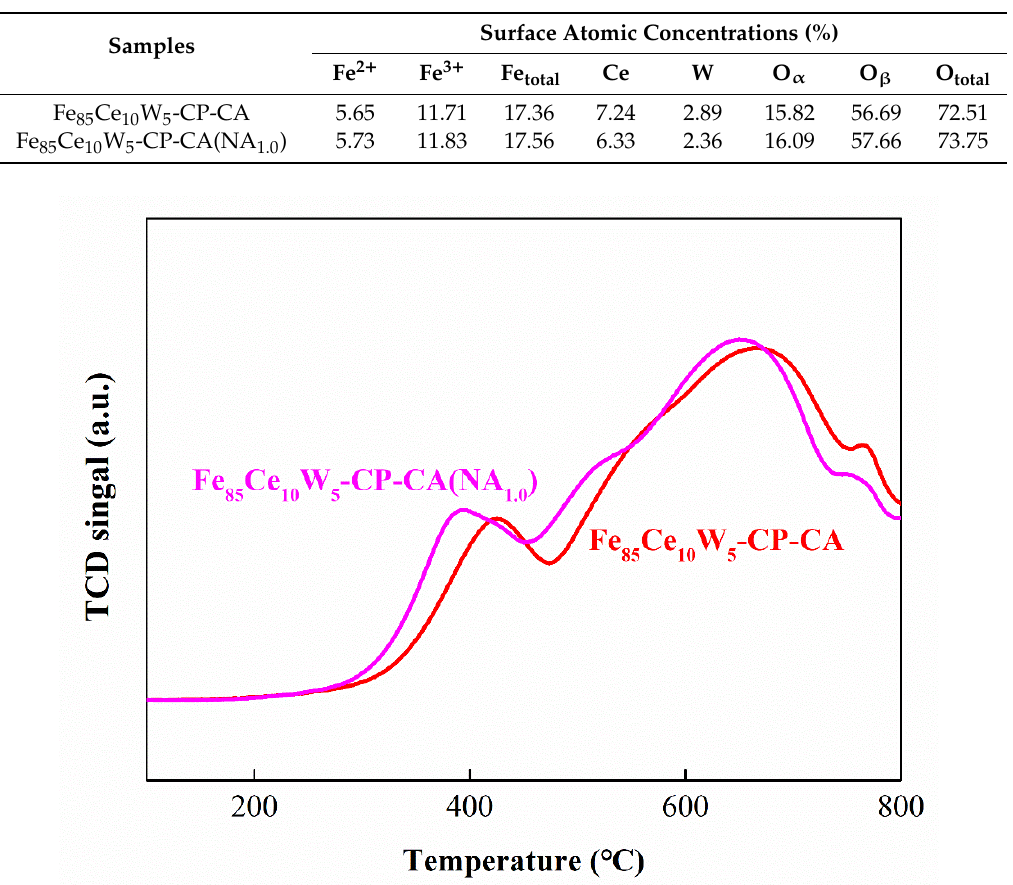
Figure 6. H 2 -temperature program reduction (H 2 -TPR) profiles of the catalysts. Table 3. The X-ray photoelectron spectroscopy (XPS) results of catalysts.